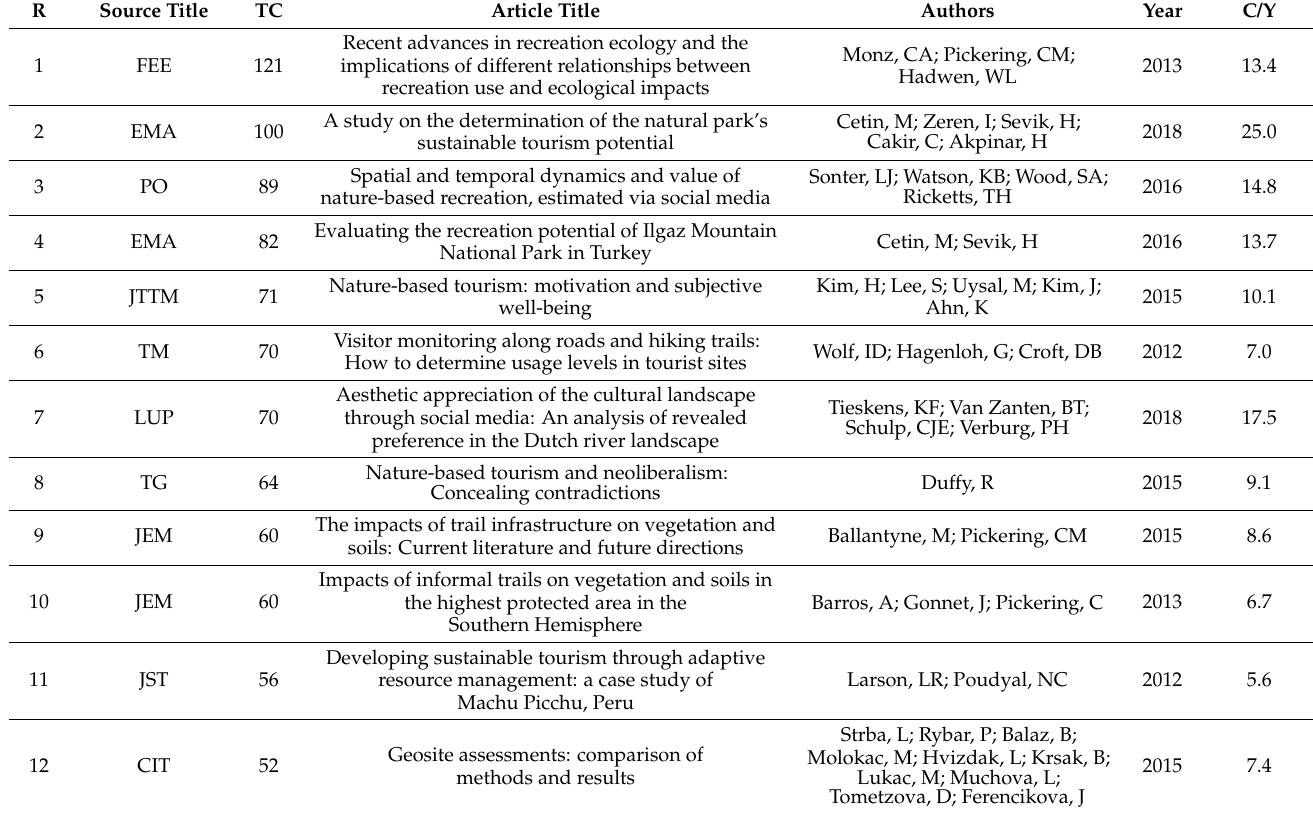
Table 4. The 30 most cited papers regarding hiking and